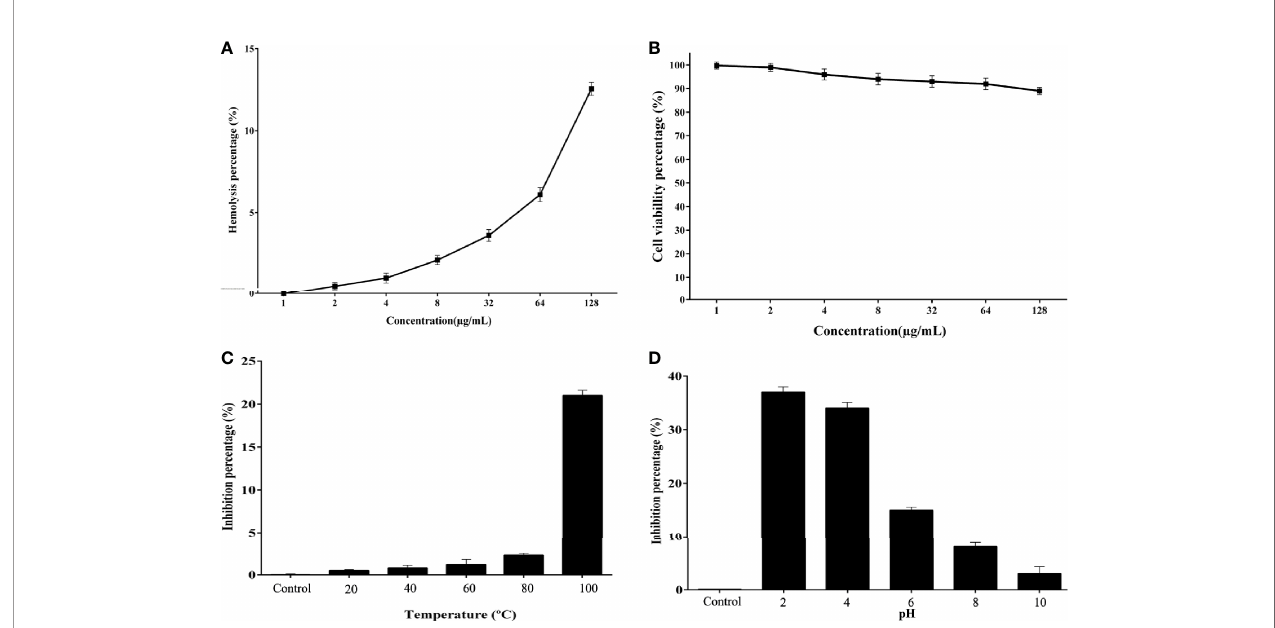
FIGURE 4 | Hemolytic effect, cytotoxic effect, and stability of Cc-AFP1. (A) Cc-AFP1 hemolytic effect against human erythrocytes. (B) Cytotoxic effect of Cc-AFP1 against HEK293 cells. (C, D) The temperature (C) and pH (D) effects on the antifungal effect of Cc-AFP1 against A. fumigatus cells. Values are provided as mean ± SD.